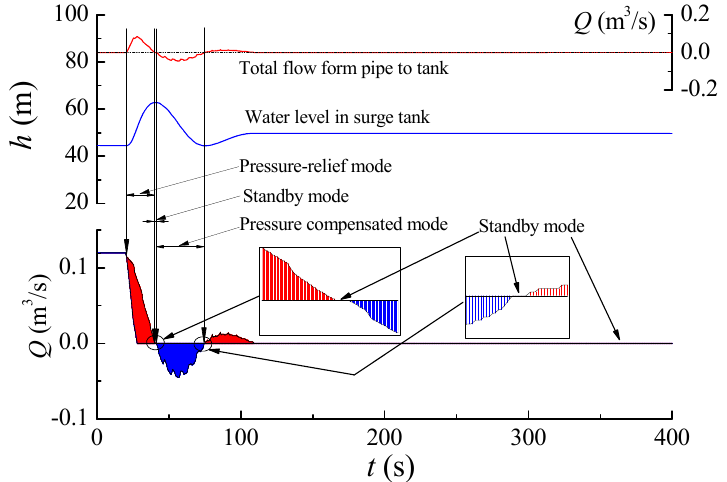
Figure 10. Flow process in surge tank with the pressure.